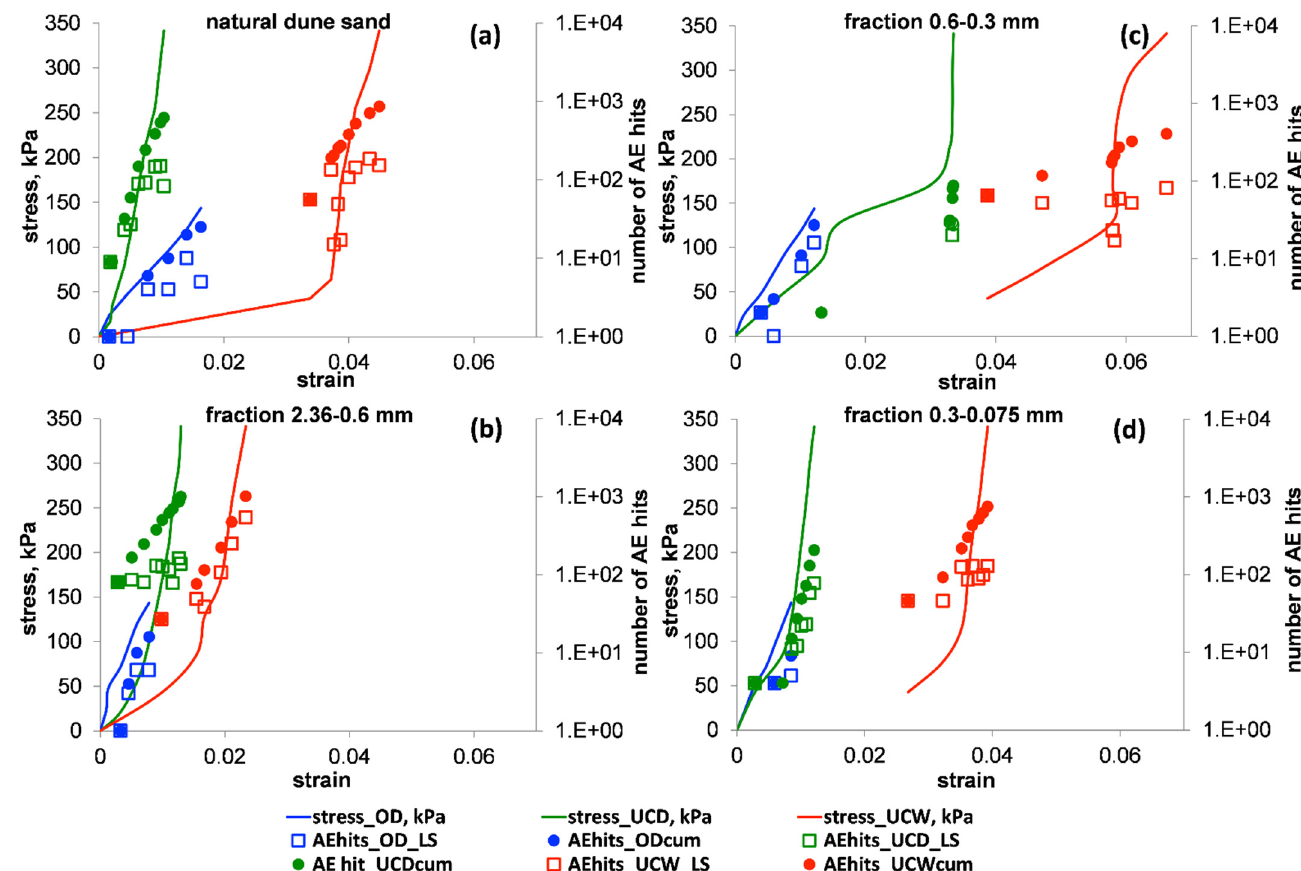
Figure 7. The stress–strain relationships (solid curves) vs. the values of the AE hit number (AEhits) for the OD (blue), UCD (green) and UCW (red) tests. The empty squares and the full circles denote the number of AE hits per loading stage (index = LS) and the cumulative number of AE hits (index = cum), respectively. Panels ( a – d ) illustrate the results for natural dune sand and its three extracted fractions: 2.36–0.6, 0.6–0.3 and 0.3–0.075 mm, respectively. Note that in the used number format, the notation “E ± xx” is part of a scientific notation and corresponds to “ · 10 ± xx